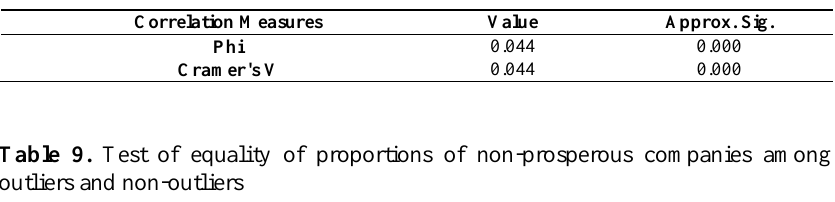
Table 8. Correlation measures of variables “being an outlier” and “being a non- prosperous company”